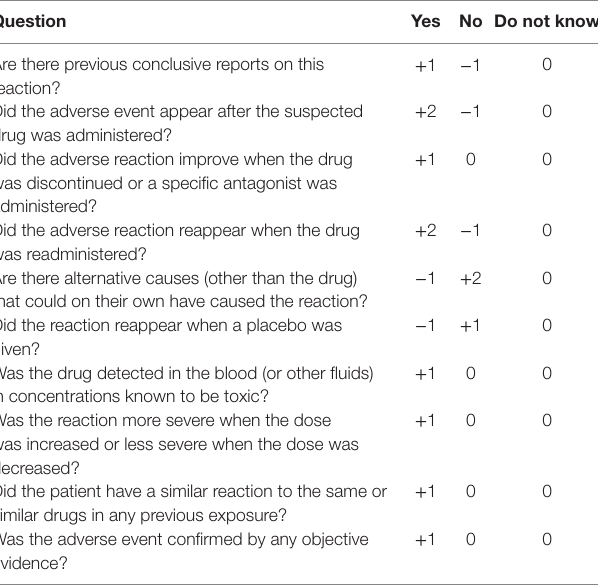
TaBle 1 | classification of skin lesions with the naranjo probability